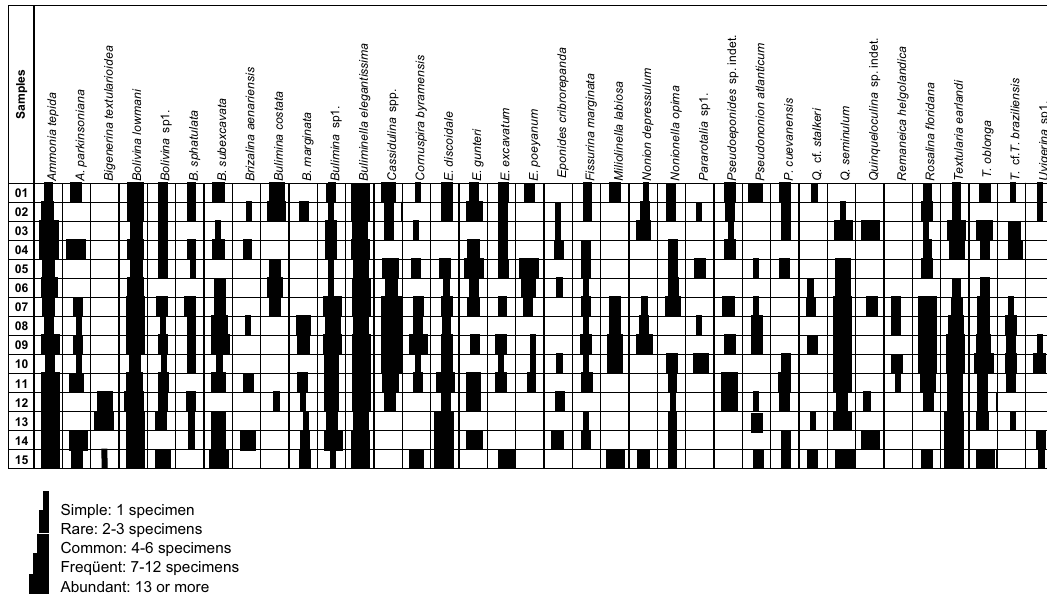
Fig. 3 – Benthic foraminifera relative abundance in samples from Niterói, Guanabara Bay. Species with Rare occurrence in 3 samples or less were not